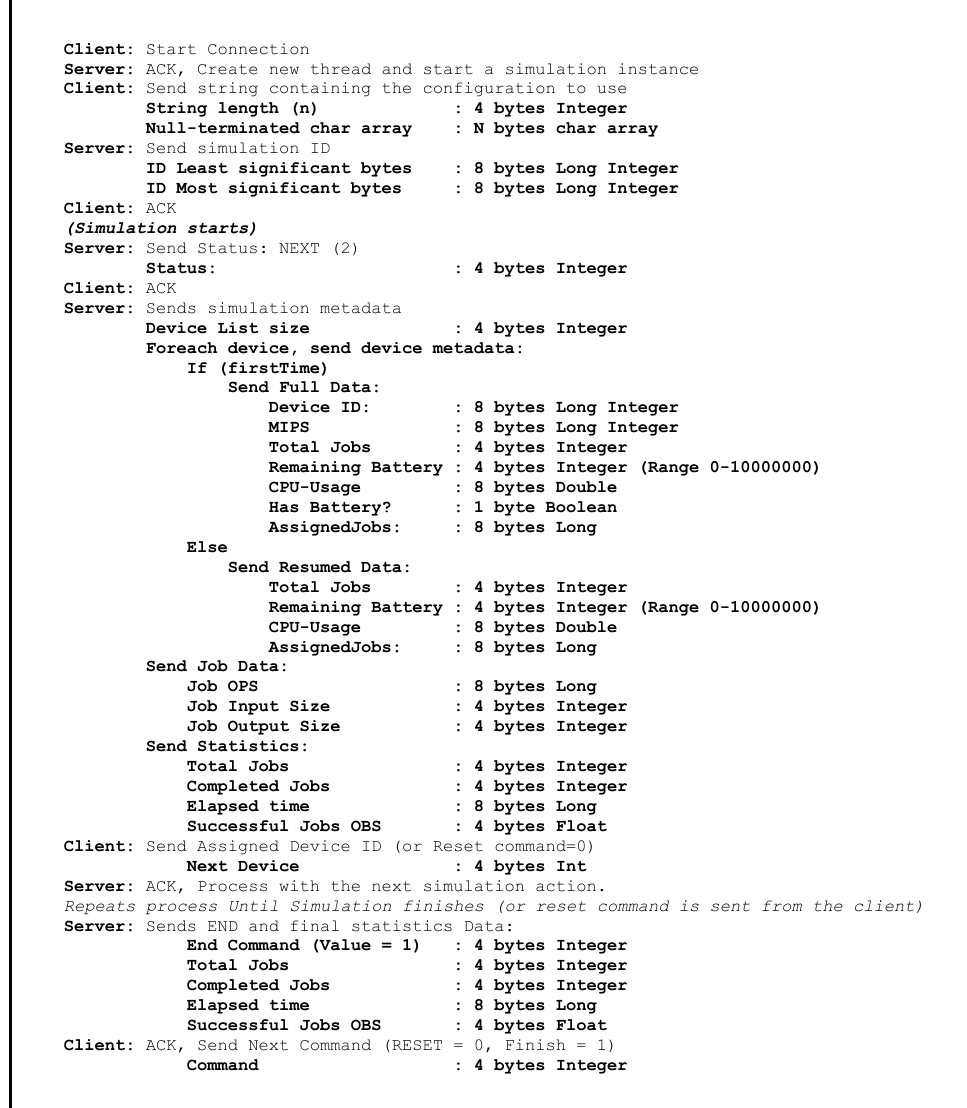
Figure A2. Client/Server communication